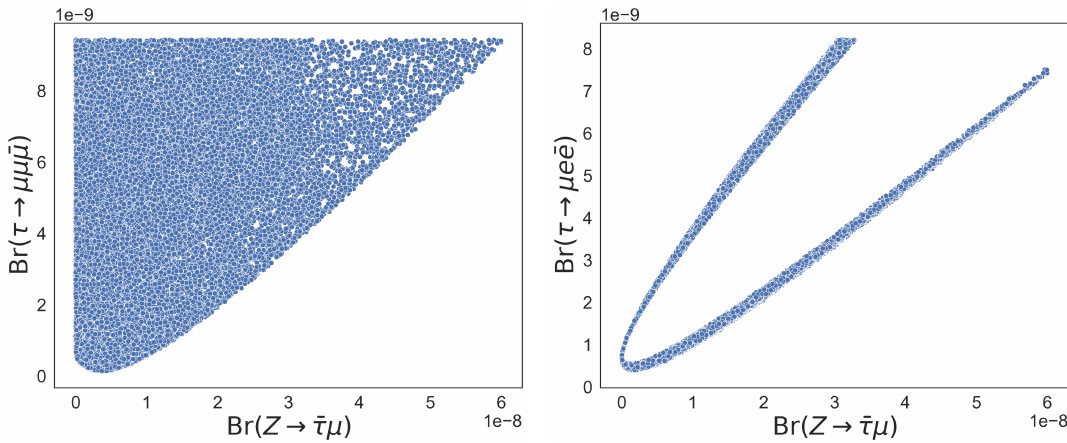
Figure 14 . Br( Z → ¯ τµ ) vs. Br( τ → µe ¯ e ) .